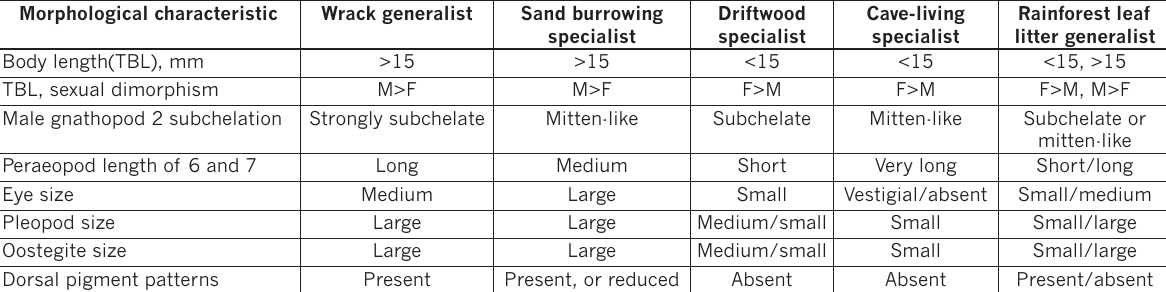
Table 3. Characteristic adaptations of talitrids (mainly from the Northeast Atlantic and Mediterranean Sea regions). Morphological characteristic